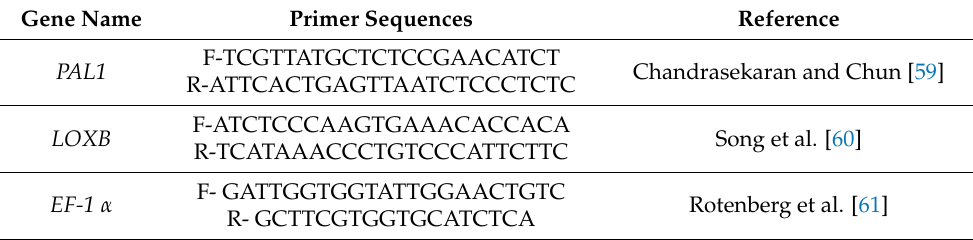
Table 1. The list of the primers used in qPCR experiment.